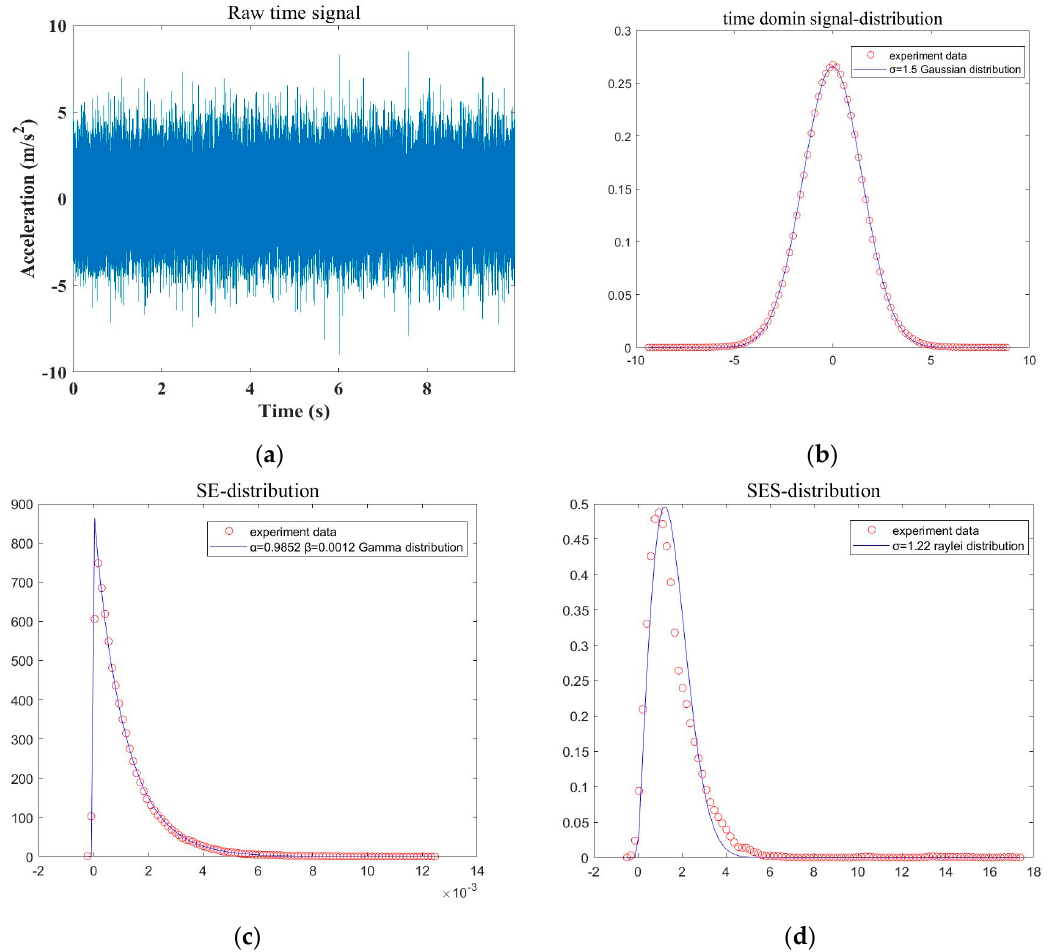
Figure 5. Pump vibration signals x ( t ) , and di ff erent distribution fittings for the signal x ( t ) , square-envelope (SE) X ( t ) , and square-envelope spectrum (SES) X ( f ) , respectively. ( a ) Measured vibrational acceleration signals from a centrifugal pump, noted as random signals x ( t ) ; ( b ) Gaussian distribution fitting for random signals x ( t ) , and x ( t ) ∼ N ( 0, σ 2 ) , with σ = 1.5 and fitting error RMSE = 0.0013; ( c ) Gamma distribution fitting for square-envelope (SE) X ( t ) , and X ( t ) ∼ Gamma ( α , β ) , with α = 0.9852, β = 0.0012, and RMSE = 4.0892, where X ( t ) is derived from Equation (5); ( d ) Rayleigh distribution fitting for the square-envelope spectrum (SES) X ( f ) , and X ( f ) ∼ Rayleigh ( σ 2 ) , with σ = 1.22 and MSE = 0.0296, where X ( f ) is derived from Equation (8) .